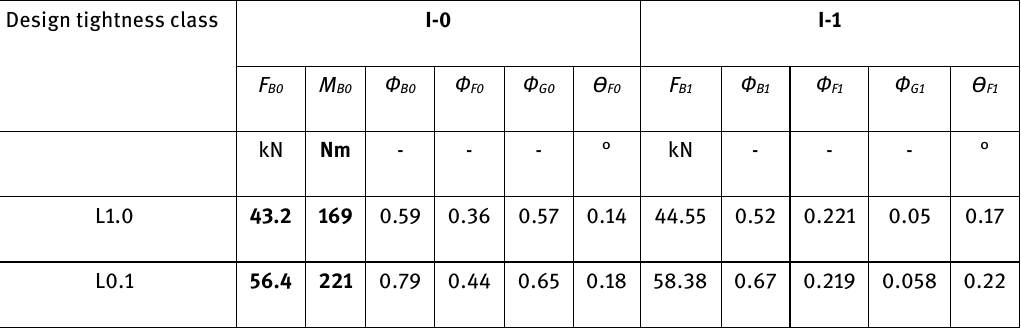
Table 2: The selected results of the flange-bolted PN40 DN 100 gasketed with material FG_1 Design tightness class